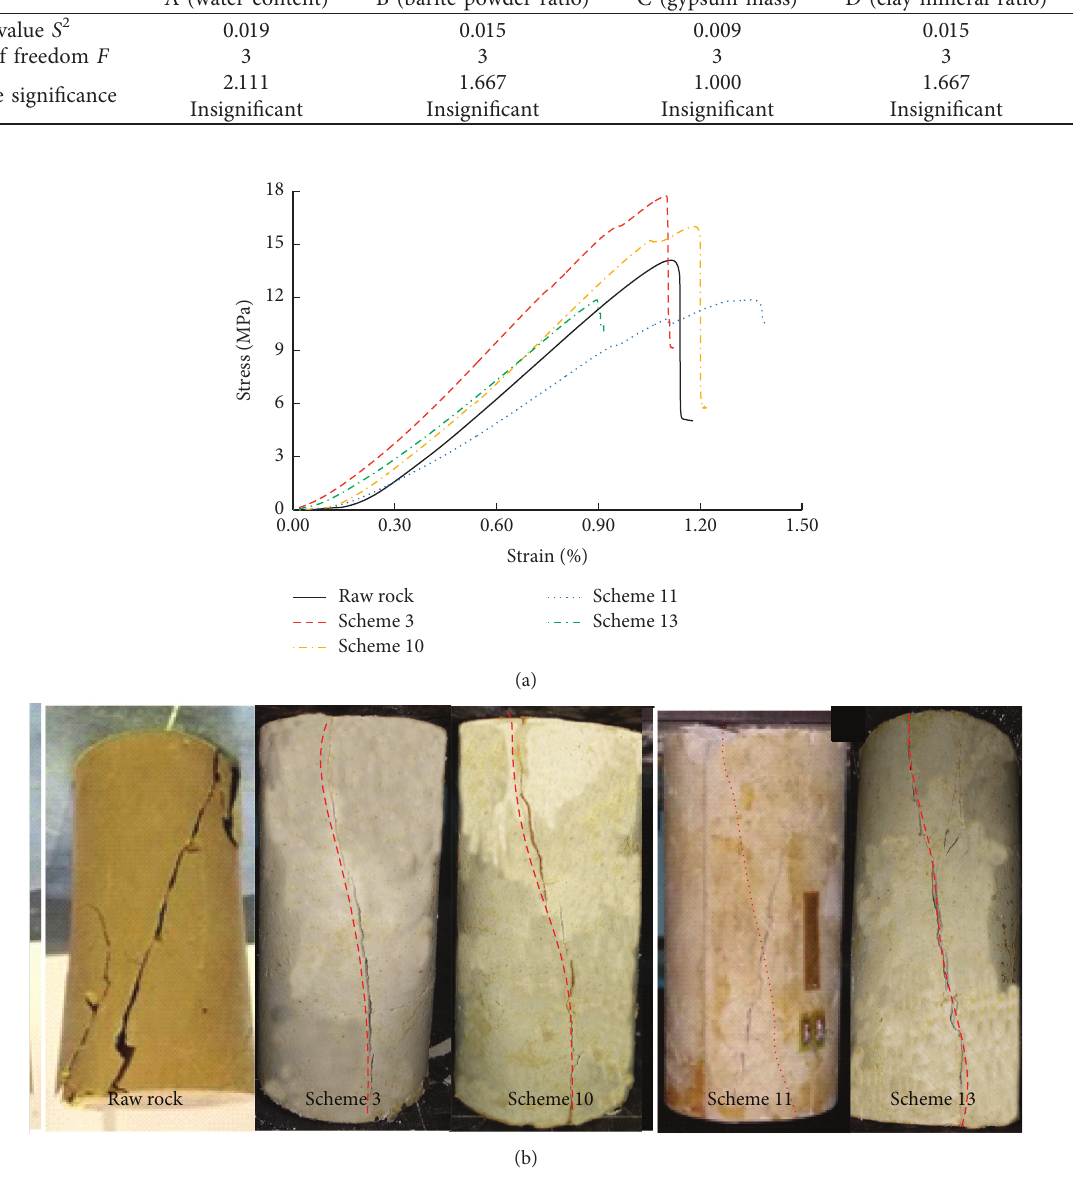
Figure 10: Typical stress-strain curve and failure modes diagram: (a) stress-strain curves; (b) failure